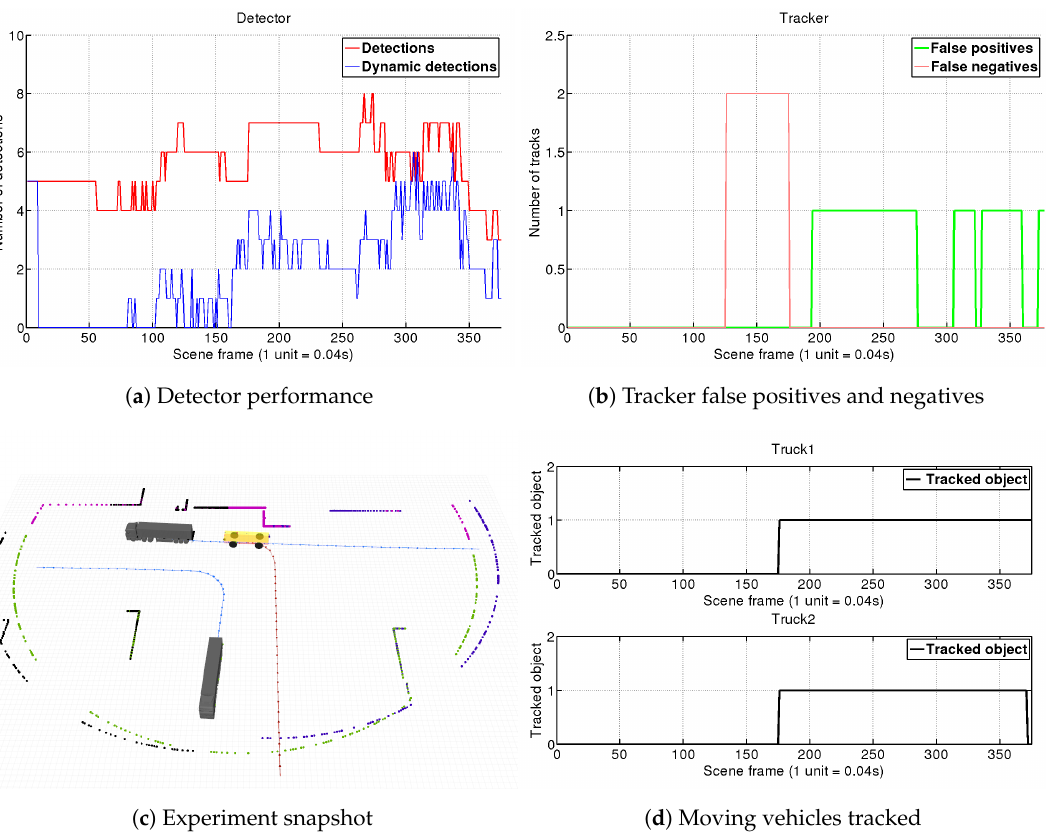
Figure 11. Scene 2. Our AGV approximates to an intersection for turning left. Truck 2 comes from its left side and turns right. Truck 1 comes from the right side and cross the intersection. When the intersection is free, the AGV turns left following Truck 1 . Our system detects and tracks correctly